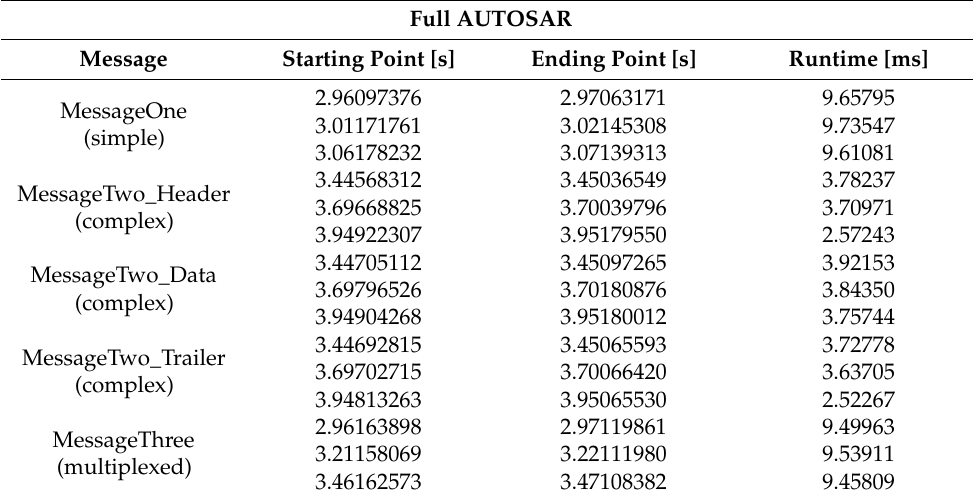
Table 4. Runtime measurements results for Full AUTOSAR.